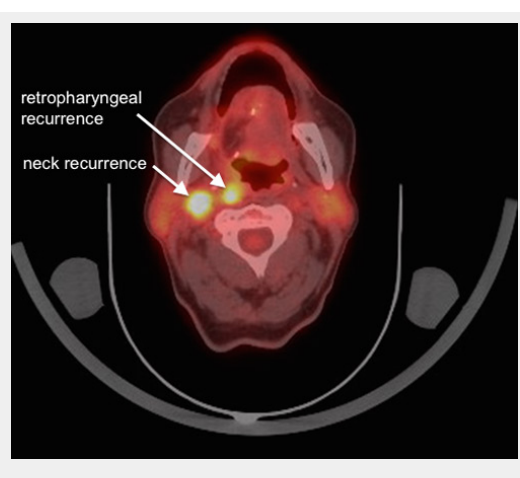
The same follow-up 18F-FDG-PET/CT scan showing the fused 18F-FDG-PET part with the CT part. There is no evidence for local recurrence at the reconstruction site however there are two highly suspicious lymph nodes in level IIb ipsilateral and